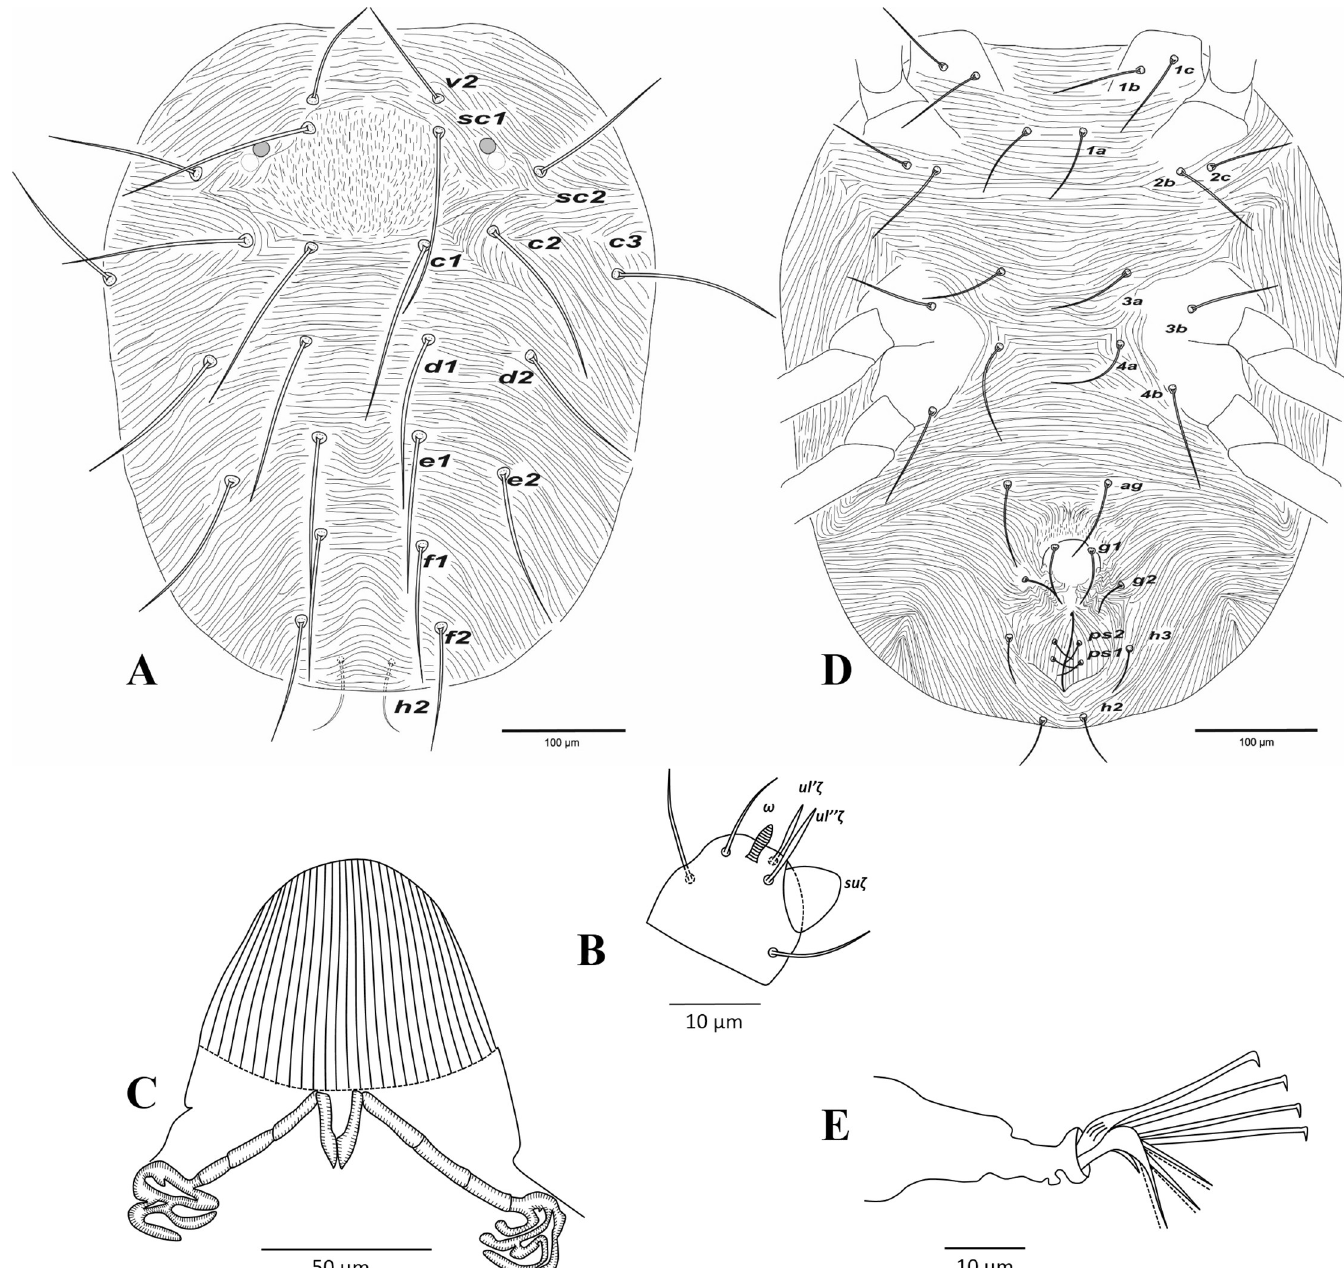
Fig 1. Amphitetranychus quercivorus , female—A. Dorsum, B. Distal segment of palpus, C. Peritremes, D. Venter, E. Empodium of leg I.